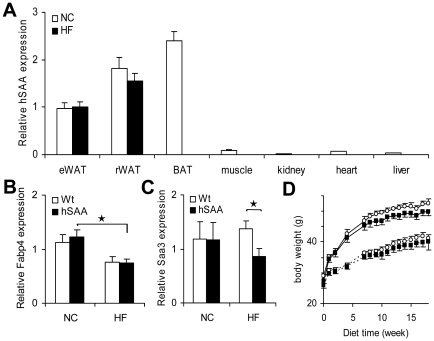
Analyses in hSAA transgenic male mice: gene expression, and animal growth.(A) hSAA gene expression in various tissues including epididymal white adipose tissue (eWAT), retroperitoneal white adipose tissue (rWAT) and brown adipose tissue (BAT) was measured in hSAA transgenic animals (n = 7) fed NC diet. hSAA gene expression was also measured in eWAT and rWAT from hSAA mice (n = 10) after 18 weeks of HF diet. Expression was normalized to Rplp0. (B) and (C) Gene expression of Fabp4 and Saa3 in eWAT (n = 7–10 male animals in each group), respectively. Expression was normalized to Rplp0. (D) Growth curves of wild type and hSAA transgenic animals fed NC (dashed line) or HF (solid line) diet for 18 weeks. Open circles, wild type mice; filled squares hSAA mice (n = 7–10 per group).*, p<0.05. Values are given as mean ± SEM.